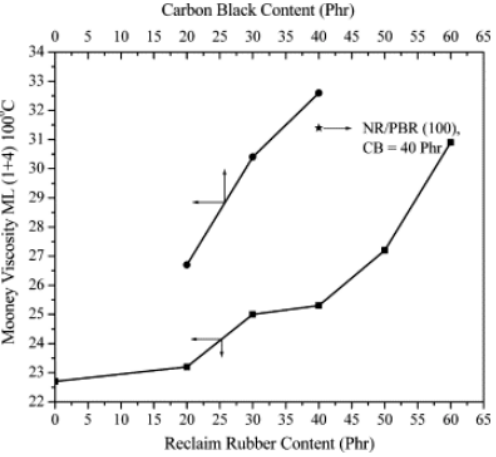
Figure 20. Mooney viscosity of NR-PBR / RR blends as a function of carbon black / regenerated tire rubber (RTR) loading (reproduced with permission from [121]).